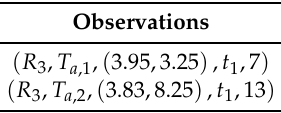
Table 2. Readings of aggregated tags by reader R 3 .